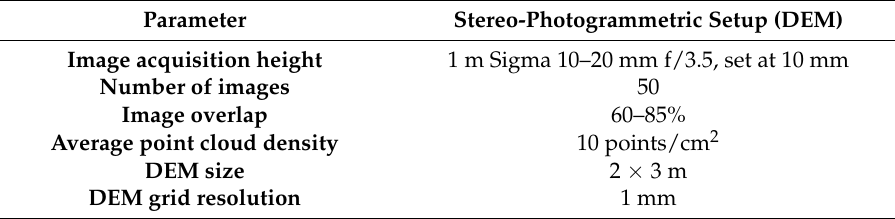
Figure 4. The perspective model of DTM in Agisoft ( a ) and the export DEM ( b ). Table 3. Characteristics of DEM.